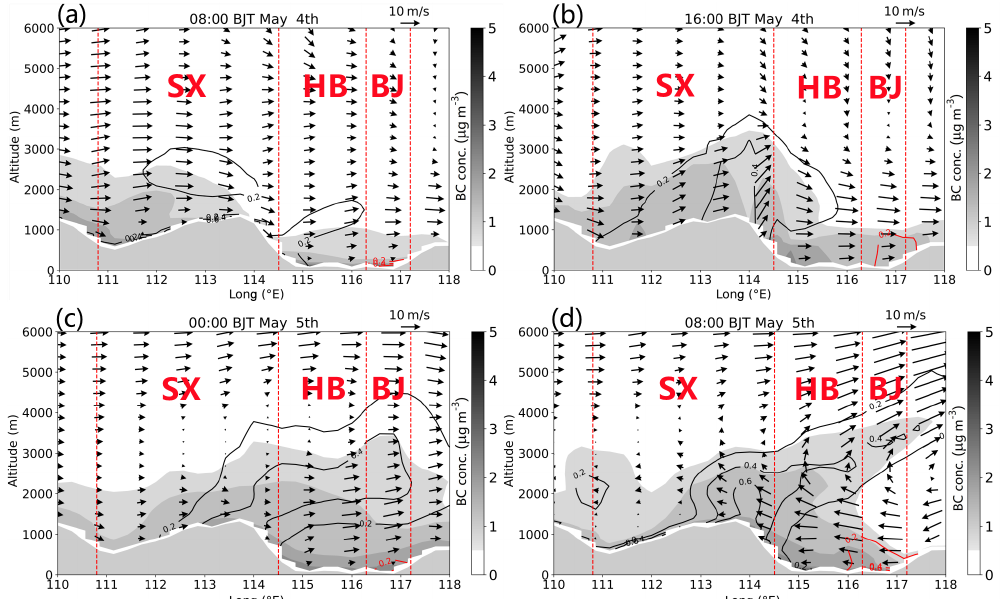
Figure 8. Vertical cross sections of BC concentration from SX to BJ and wind vectors (arrows) where the vertical speed is multiplied by 100 at (a) 08:00BJT on 4 May, (b) 16:00BJT on 4 May, (c) 00:00BJT on 5 May, and (d) 08:00BJT on 5 May. The black line is the BC contour lines of SX plus NWCHN, and the red line is the BC contour line of BJ.